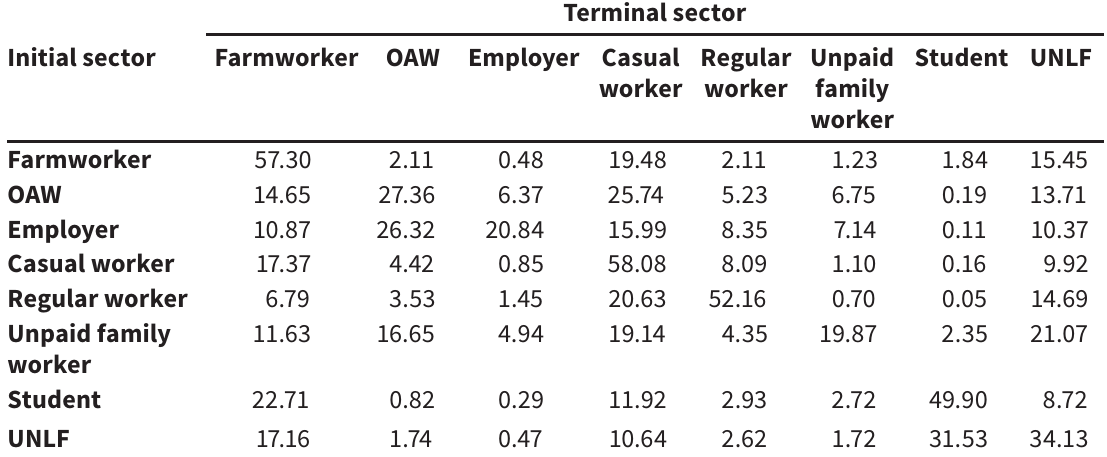
Terminal sector